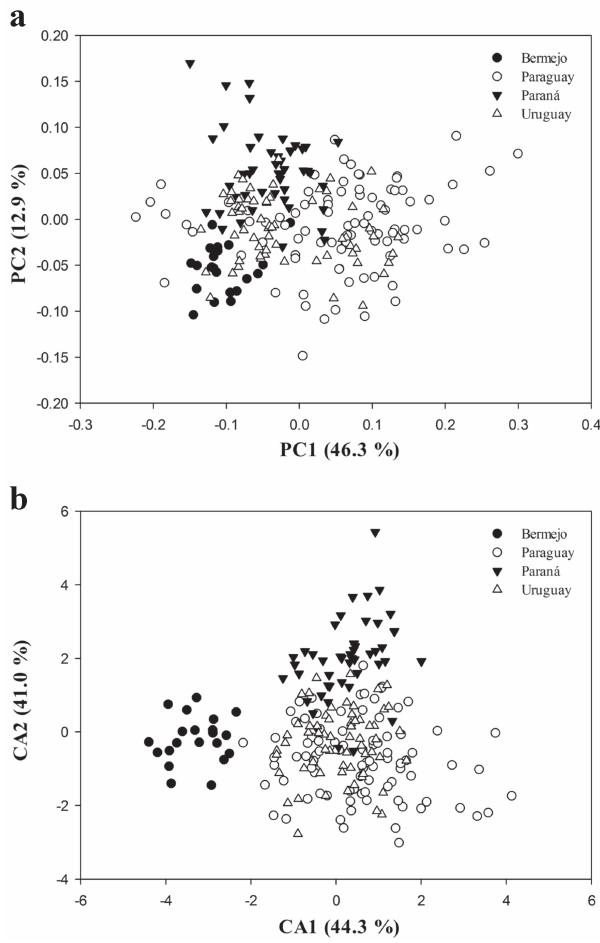
Fig. 2. Most discriminant axes obtained from the size-free multivariate analyses using the adjusted morphometric data of Moenkhausia bonita . a. principal component analysis; b. discriminant canonical analysis. Tab. 3. Confusion matrix showing classification of Moenkhausia bonita to geographic group using the adjusted morphometric (A) and meristic (B) data (bold values indicate correct classifications). Column: predicted group, rows: given